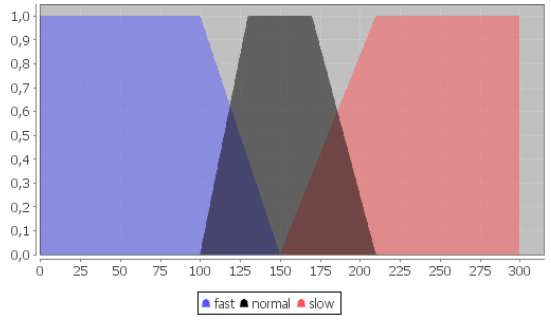
Figure 4. Examples of membership function of variable time spent .